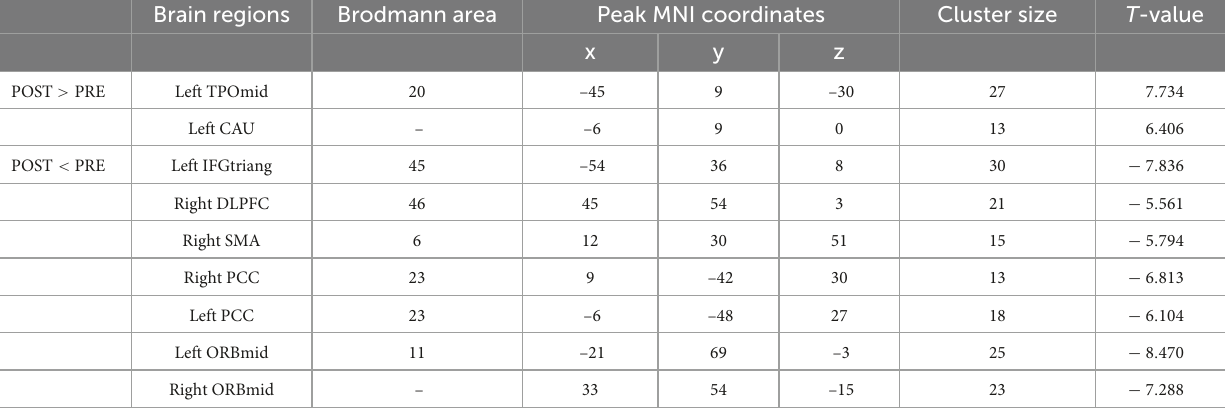
TABLE 4 Brain regions demonstrating altered fALFF values of PED patients after electroacupuncture. Brain regions Brodmann area Peak MNI